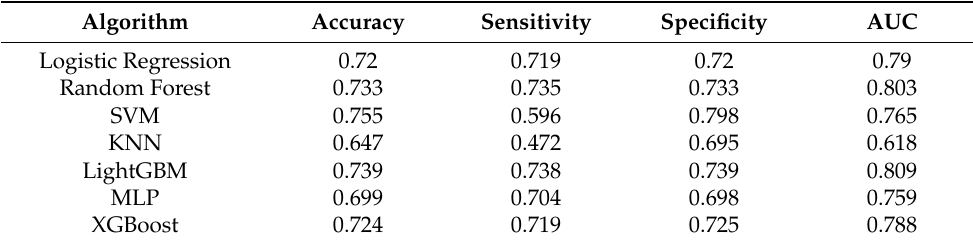
Figure 4. ROC of acute respiratory failure in patients with COPD. Table 4. Testing results of the predictive models for ventilator dependence.